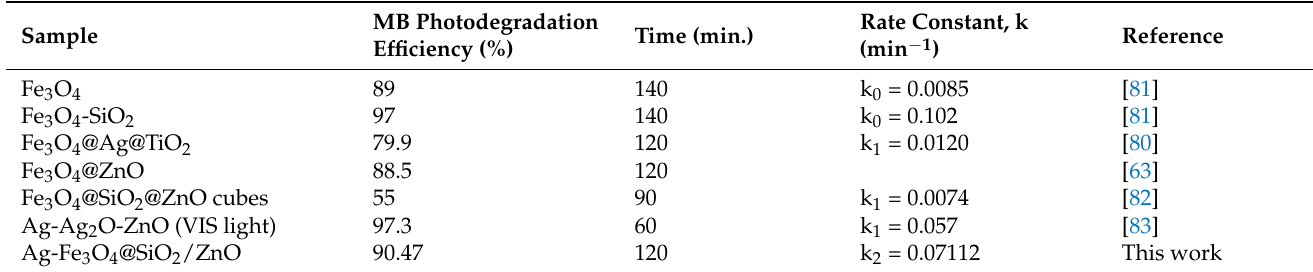
Table 4. Photocatalysis performances of some